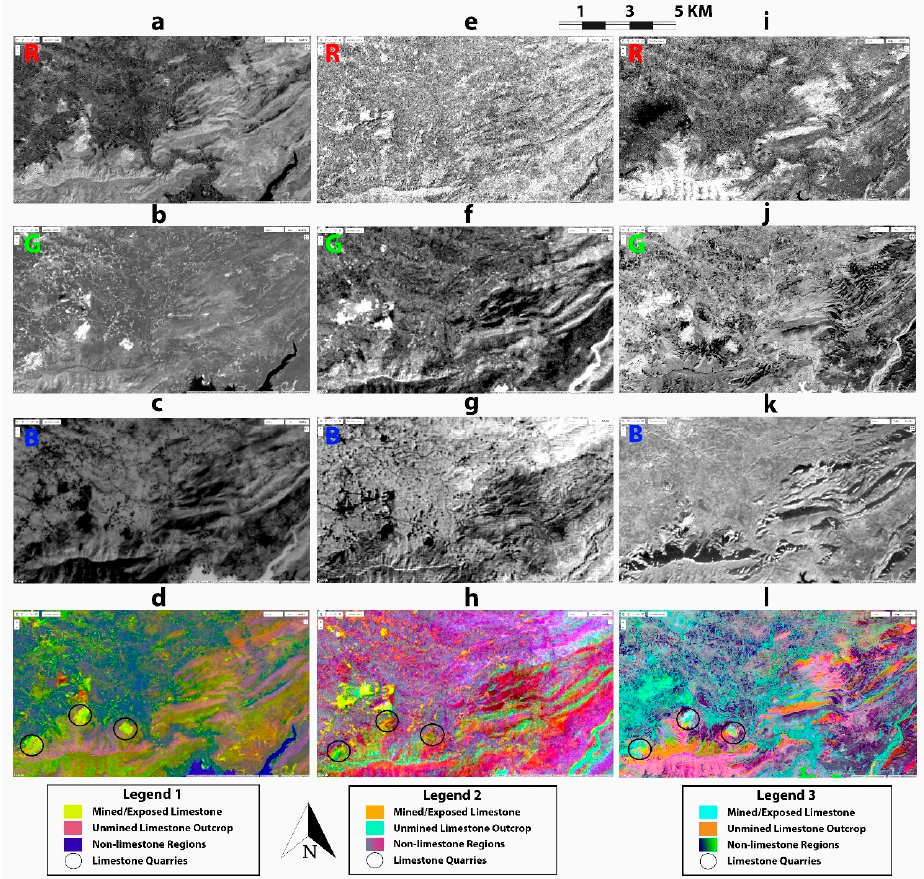
Figure 4. PC images of Landsat-8 ( a ) PC5 (limestone is shown as bright) ( b ) PC4 (limestone is shown as bright) ( c ) PC2 (limestone is shown as dark); ASTER ( e ) PC6 (limestone is shown as bright) ( f ) PC4 (limestone is shown as bright) ( g ) PC2 (limestone is shown as dark); Sentinel-2 ( i ) PC5 (limestone is shown as bright) ( j ) PC3 (limestone is shown as bright) ( k ) PC2 (limestone is shown as dark) and their FCCs ( d ) Landsat-8 FCC of PCs, ( h ) ASTER FCC of PCs, and ( l ) Sentinel-2 FCCs of PCs for the region of interest, i.e., Hattar, Khyber Pakhtunkhwa, Pakistan.